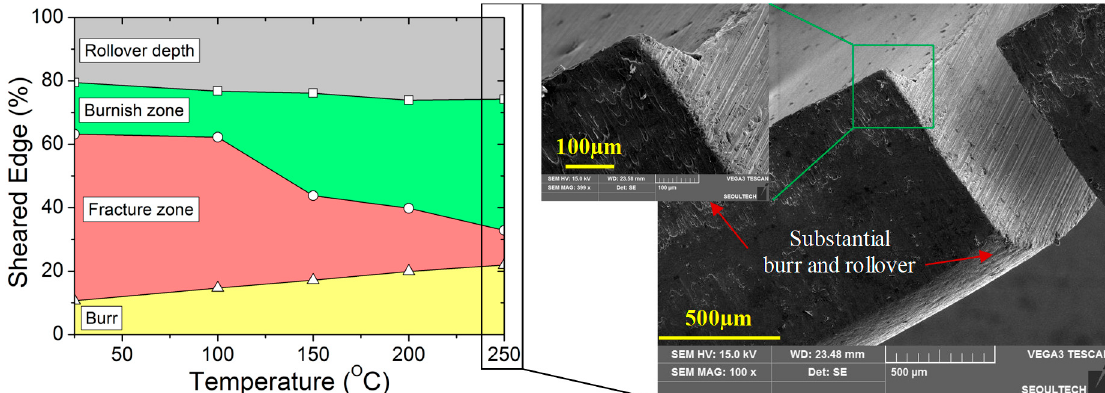
Figure 9. Relationship between characteristic dimensions of sheared edge (%) and temperature at 30% clearance, indicating a substantial rollover region and burr feature. The burr height was measured as the vertical distance between the lower plane of the workpiece and the end of the metal fragment. It was observed that the burr increases with the increase in